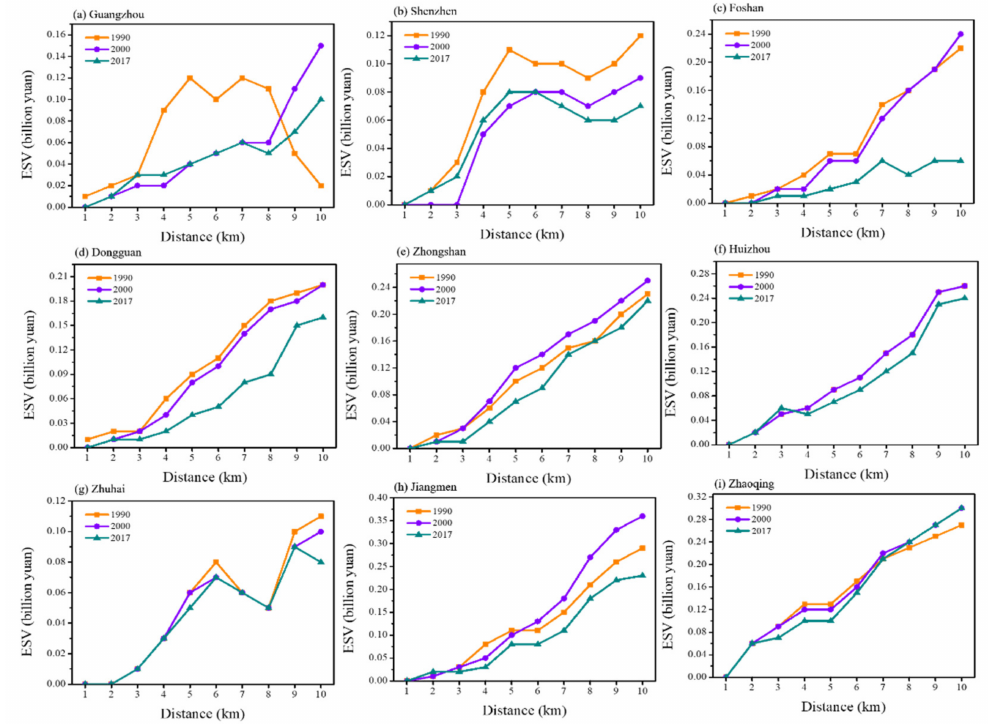
Figure 8. Changes of ESVs in ( a ) Guangzhou, ( b ) Shenzhen, ( c ) Foshan, ( d ) Dongguan, ( e ) Zhongshan, ( f ) Huizhou, ( g ) Zhuhai, ( h ) Jiangmen, ( i )